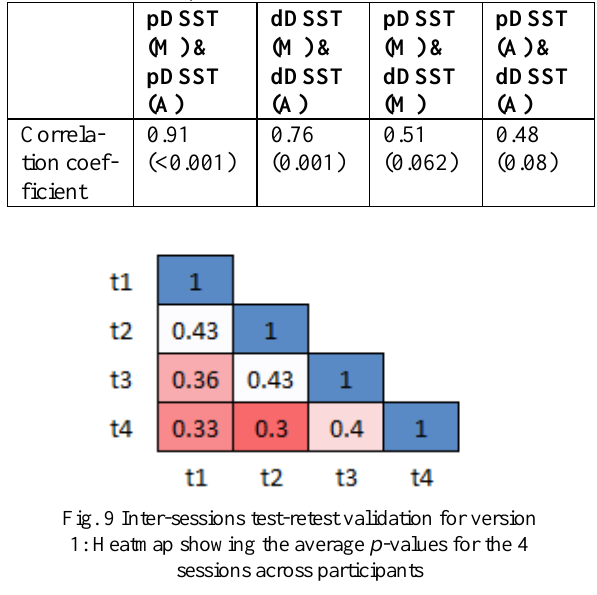
Table 7 Validation of the dDSST basic version (version 1) against the pDSST using Pearson’s correlation coefficient with p -values given in brackets.